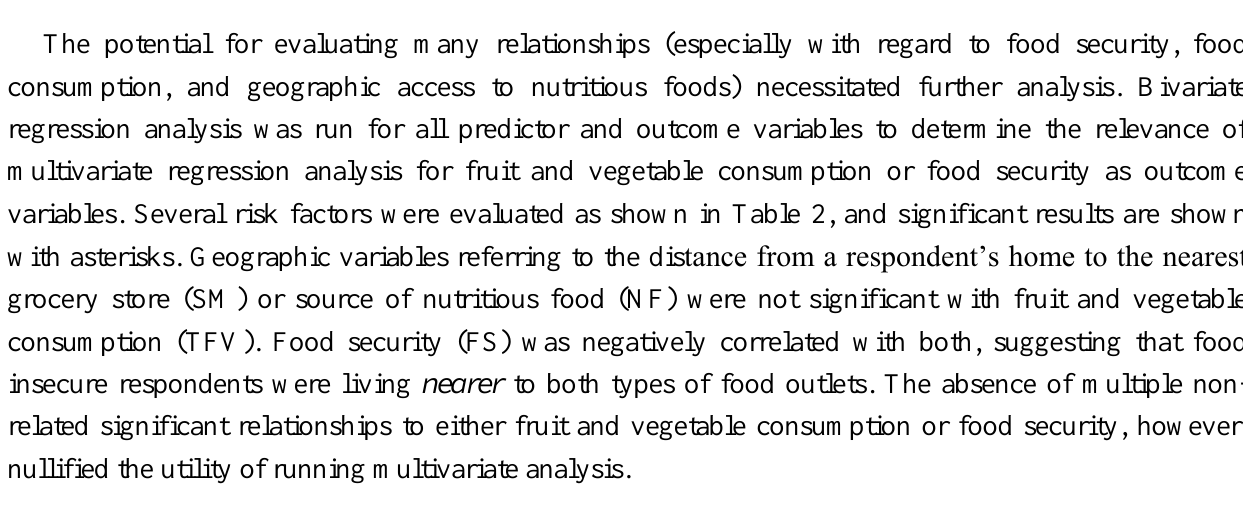
Table 2. Correlation matrix for all survey